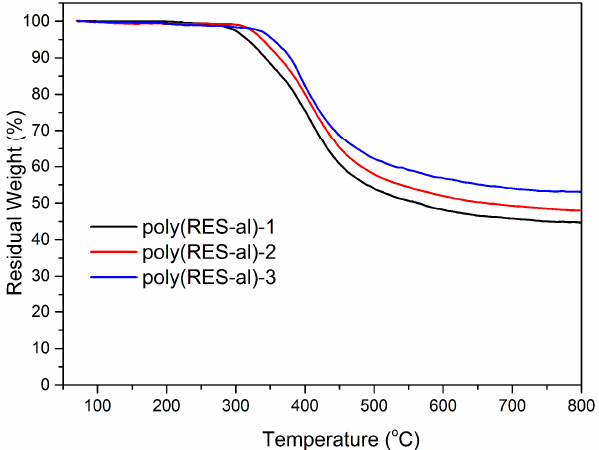
Figure 8. Thermogravimetric analysis of RES-al based thermosets in N 2 .